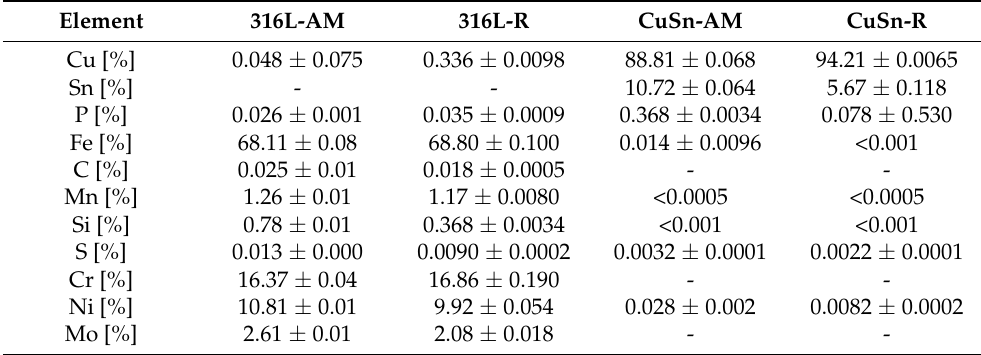
Table 3. Chemical composition of the samples.